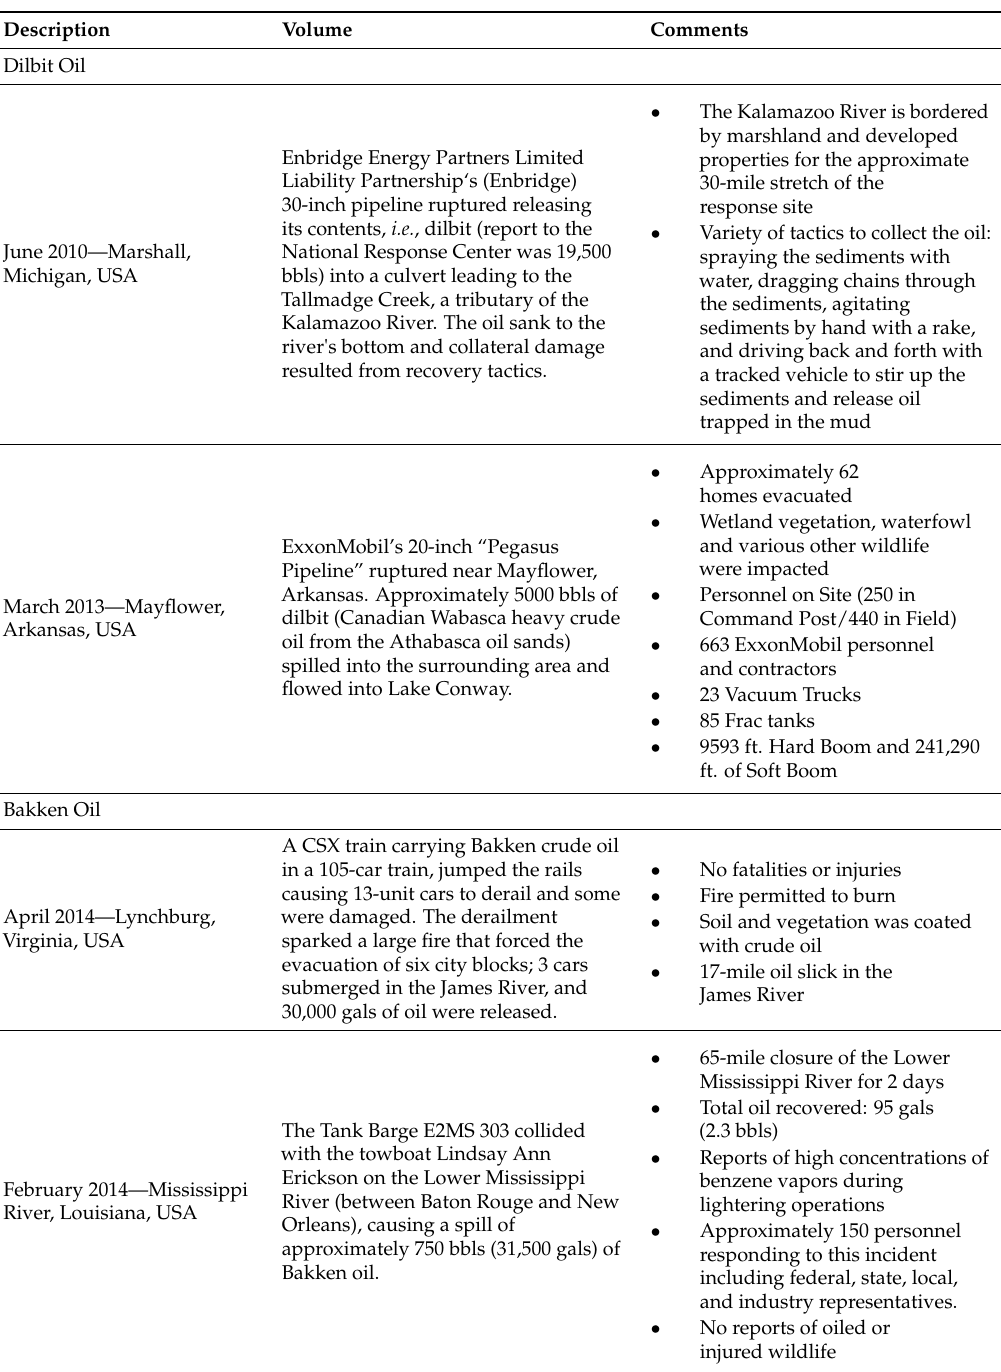
Table 1. Examples of recent transportation-related incidents involving spills of dilbit and Bakken crude oil